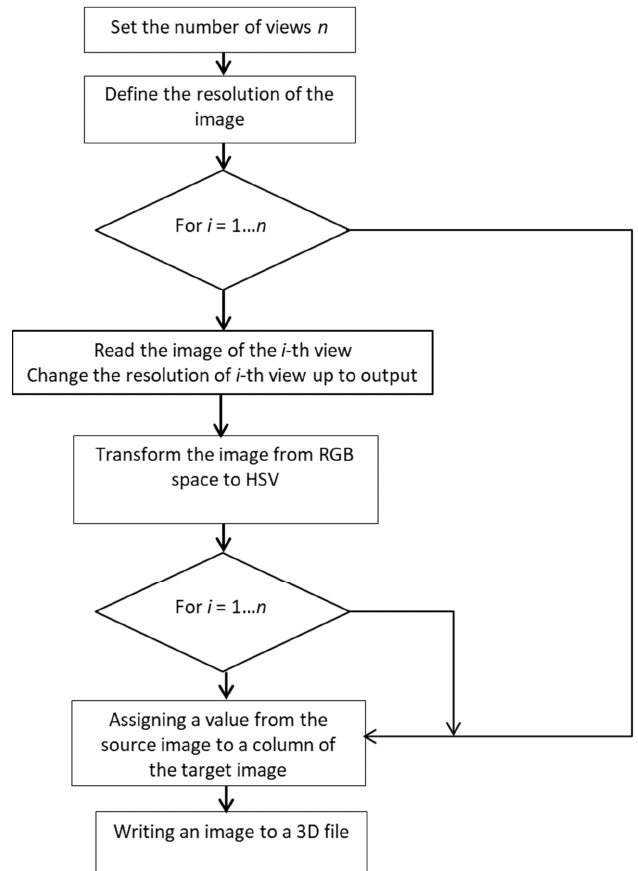
Figure 4. Flowchart of the 3D image files creation method.